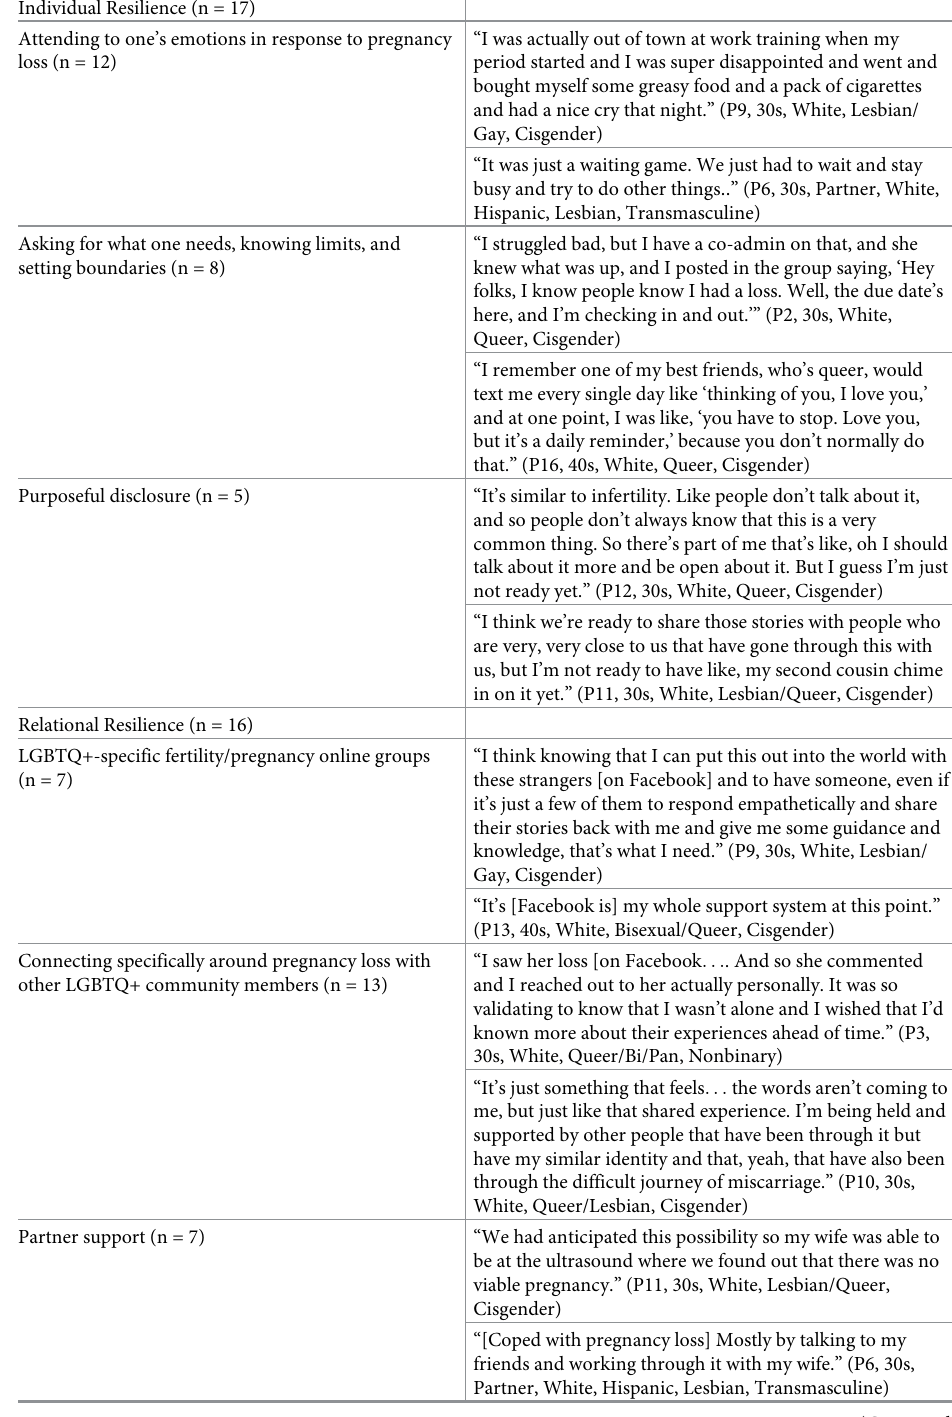
Table 4. Multi-level resilience in LGBTQ+ people’s experiences of conception, pregnancy, and loss: Sub-themes, definitions, and example